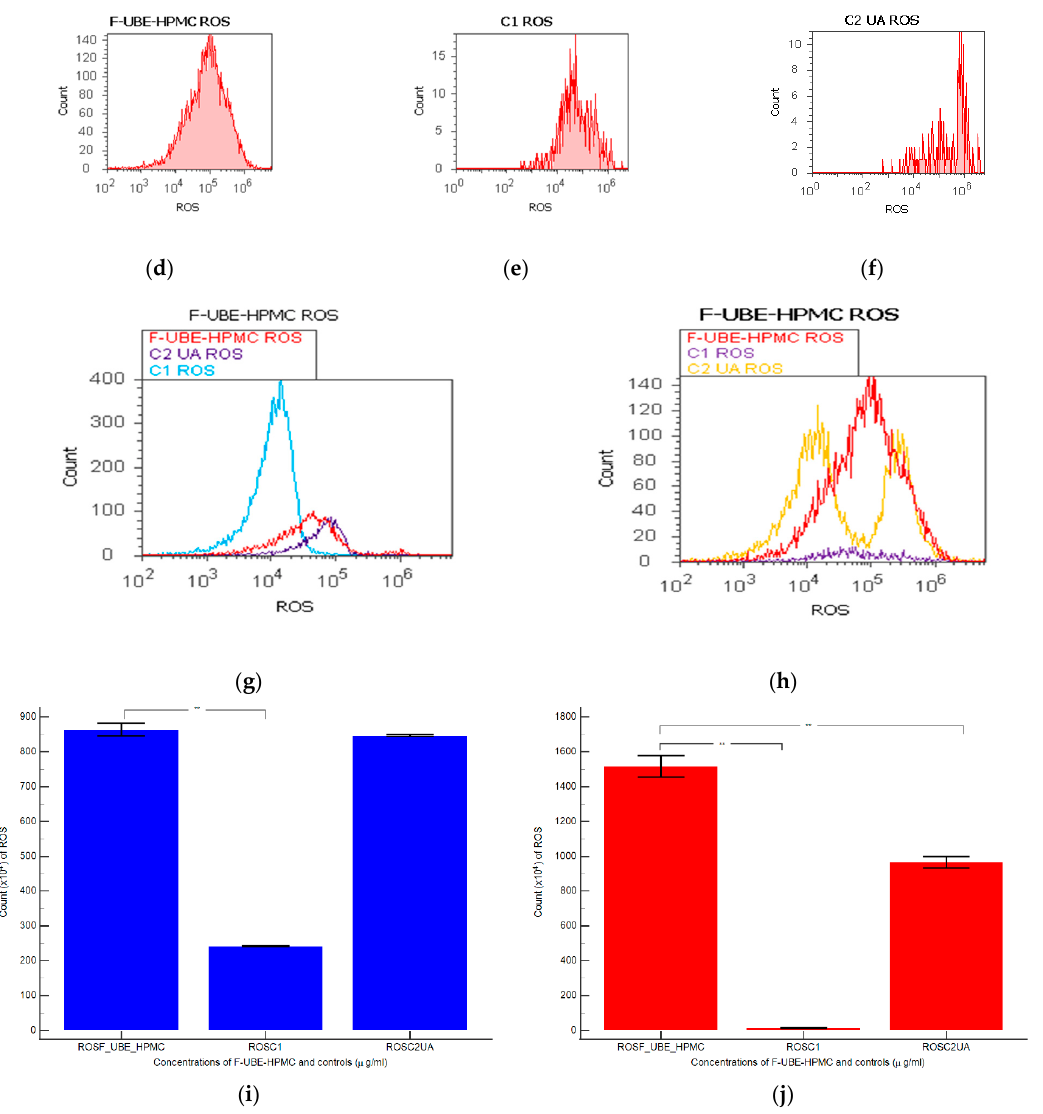
Figure 4. Reactive oxygen species (ROS) levels models in normal blood cells ( a – c ) and CLS-354 tumor cells ( d – f ) after 24 h treatment with F-UBE-HPMC. UBE-loaded mucoadhesive patches and controls extrapolated on ROS axis ( g , h ) in blood cells ( g ) and CLS-354 tumor cells ( h ); F-UBE-HPMC—mucoadhesive oral patch loaded with U. barbata dry ethanol extract ( a , d ); C1—1% DMSO negative control ( b , e ); C2—125 µ g/mL UA-positive control ( c , f ). Statistical analysis of reactive oxygen species (ROS) in normal blood cells ( i ) and CLS-354 tumor cells ( j ). ** p < 0.01 evidence of significant statistical differences between controls and F-UBE-HPMC made by paired samples t -test; F-UBE-HPMC—mucoadhesive oral patches loaded with U. barbata (L.) dry ethanol extract; C1—negative control with 1% dimethyl sulfoxide (DMSO); C2UA—positive control with 125 µ g/mL usnic acid